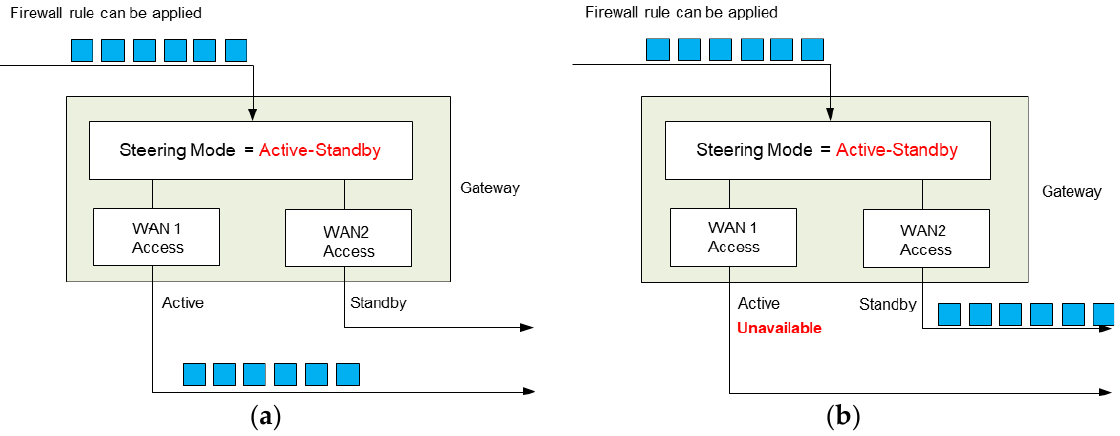
Figure 4. Interfaces between the MRGW and each RAT end-device.